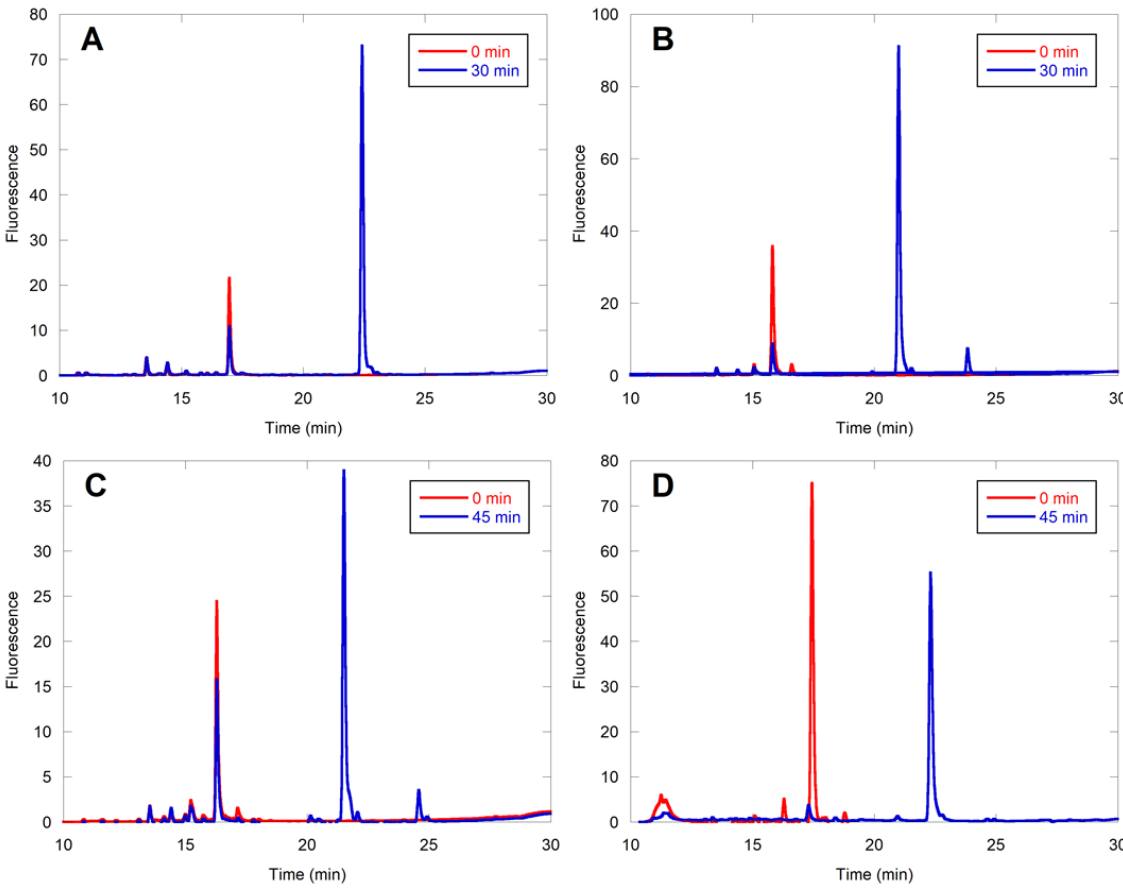
Figure 4. HPLC assays quantifying the conversion of selected peptides by the fluorescence of dansylglycine (ex. 220 nm/em. 495 nm). Reactions contained 2.4 µM peptide, 10 µM FPP, and specified FTase concentration. ( A ) DsGRAGCMIIM (25 nM yFTase); ( B ) DsGRAGCMIIQ (25 nM yFTase); ( C ) DsGCMTSQ (100 nM yFTase); ( D ) DsGCSQAS (100 nM rFTase). Chromatograms of the reaction before (red) and after enzymatic reaction (blue) are shown for each peptide. The farnesylated peptides always eluted later than their unfarnesylated counterparts. It should be noted that CMIIM and CMIIQ are sequences obtained from initial screening of peptide libraries via MALDI whereas CMTSQ and CSQAS are sequences identified from bioinformatic analysis of human genome sequences, guided by the results from the library screening.